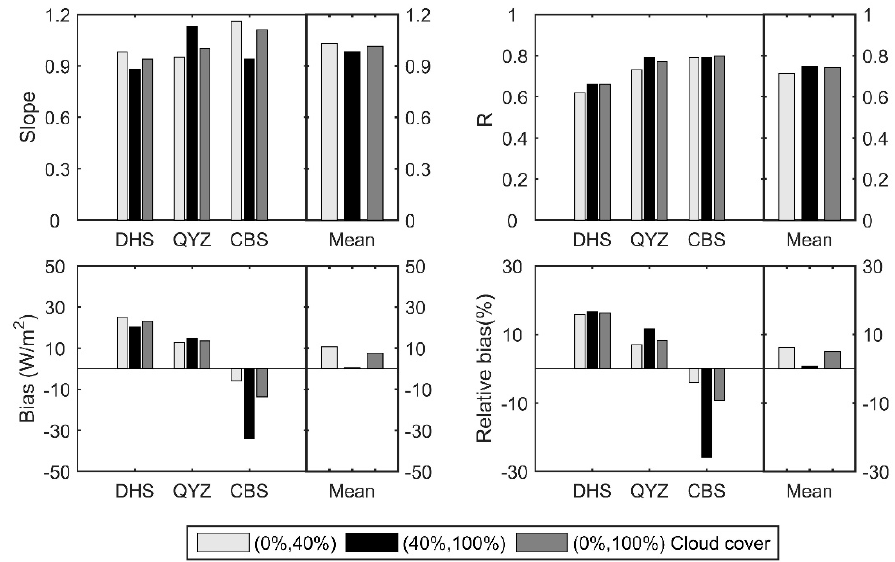
Figure 11. Statistical metrics at three sites under different cloud cover. Slope is the slope of fit line between LE cal and LE obs .